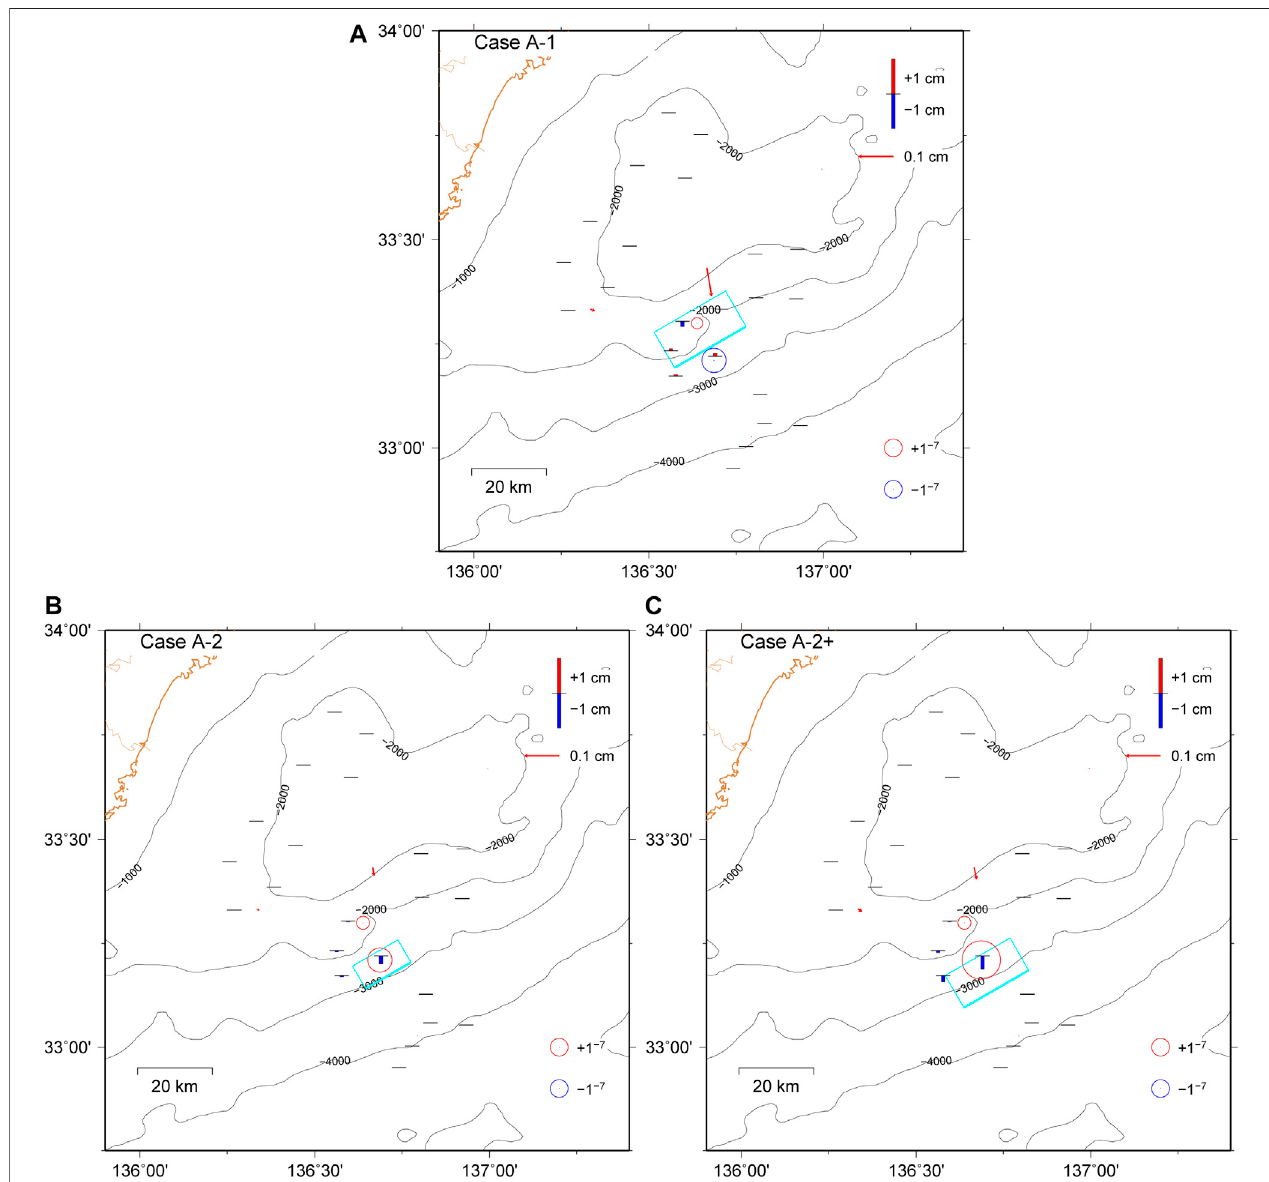
FIGURE9| Faultmodel(cyan)for (A) CaseA-1, (B) CaseA-2, (C) CaseA-2+ withtheobservedvolumetricstrains(opencircle)atC0002andC0010 andaleveling change at the DONET stations (vertical scale; uplift: red; subsidence: blue). The calculated volumetric strain change at C0002 and C0010 is listed in Table 5 . The red vectors represent the horizontal displacement at the GNSS-A stations [ Figure 1A (almost 0 for KUM01)]. The contour shows sea fl oor bathymetry (meter).